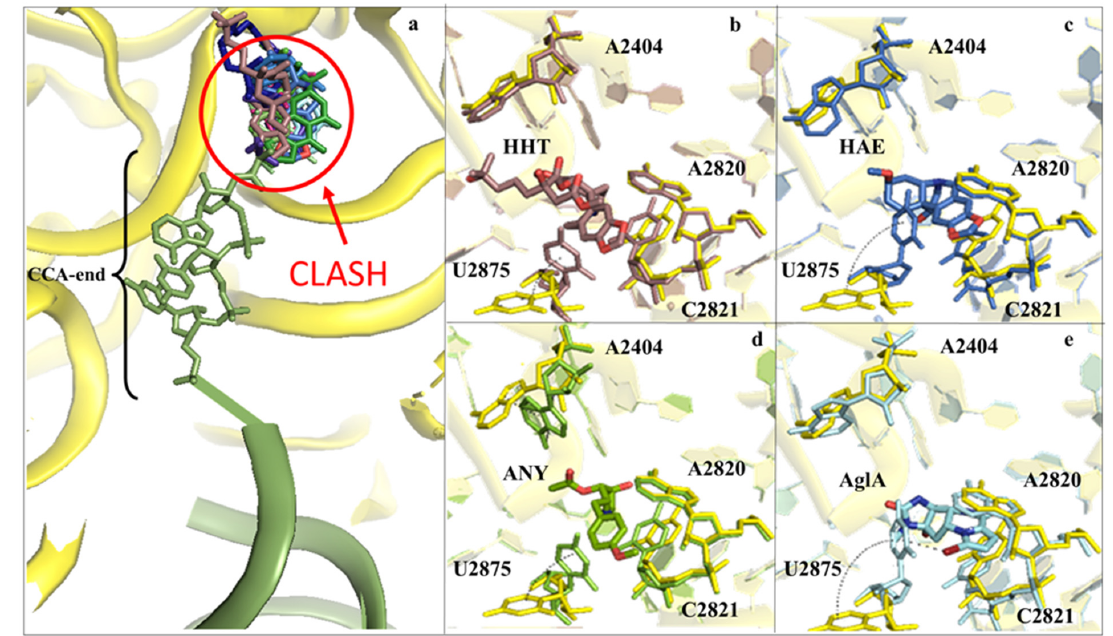
Figure 3. Inhibitors binding to the A-site cleft impede the binding of the aa-tRNA during elongation. ( a ) Overview of the inhibitors that bind to the A-site cleft. All compounds would sterically clash with the incoming charged acylated A-site tRNA, thus impairing accommodation of the following amino acid within the pocket and therefore halting the elongation phase of translation. Anisomycin (ANI) in lemon (PDB: 4U3M), agelastatin A (AglA) in cyan (PDB: 5MEI), deoxyvalenol in fuchsia (PDB: 4U53), haemanthamine (HAE) in blue (PDB: 5ON6), homoharringtonine (HHT) in brown (PDB: 4U4Q), lycorine (LYC) in light blue (PDB: 4U4U), nagilactone C in aquamarine (PDB: 4U52), narciclasine (NAR) in green forest (PDB: 4U51), T2-toxin in purple (PDB: 4U6F) and verrucarin A (PDB: 4U50) in blue navy; ( b ) zoom-in and details of interaction for HHT within the A-site cleft. Proximal rRNA residues are shown as sticks; ( c ) zoom-in and details of interaction for HAE within the A-site cleft; ( d ) zoom-in and details of interaction for ANI within the A-site cleft; ( e ) zoom-in and details of interaction for AglA within the A-site cleft. The rRNA residues that adopt different conformations upon binding of the inhibitors, A2404 and U2875, are shown for clarity. The peculiar halogen– π interaction established between the pyrimidine ring of U2875 and the bromine atom of AglA is also highlighted.